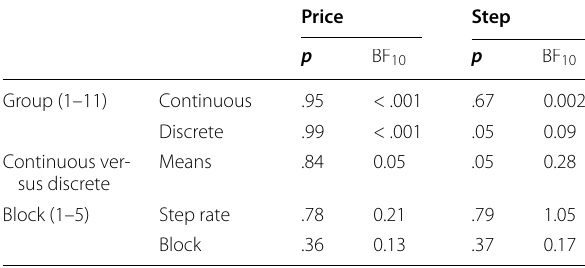
Table 2 Experiment 2 results